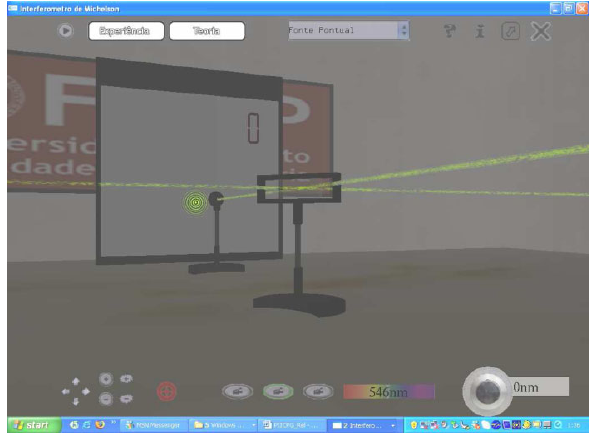
Figure 1. The Michelson interferometer virtual